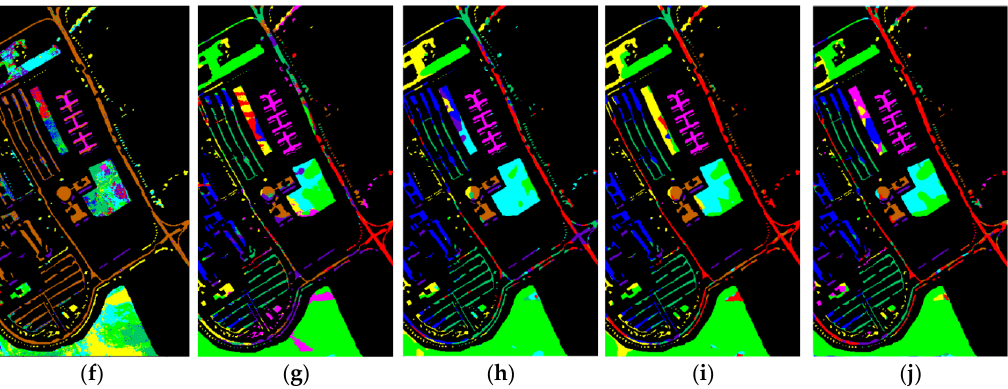
Figure 8. Classification maps resulting from nine different methods for the PU data set with three labeled samples per class. ( a ) Ground-truth. ( b ) Semi-1D CNN (18.25%). ( c ) 3D FCN (50.48%). ( d ) Semi-3D CNN (35.54%). ( e ) 3D CNN (52.10%). ( f ) 1D RNN (28.85%). ( g ) HybridSN (64.06%). ( h ) 3DCSN (65.08%). ( i ) MDSN (68.39%). ( j ) 3D-FHOG + MDSN (73.29%).